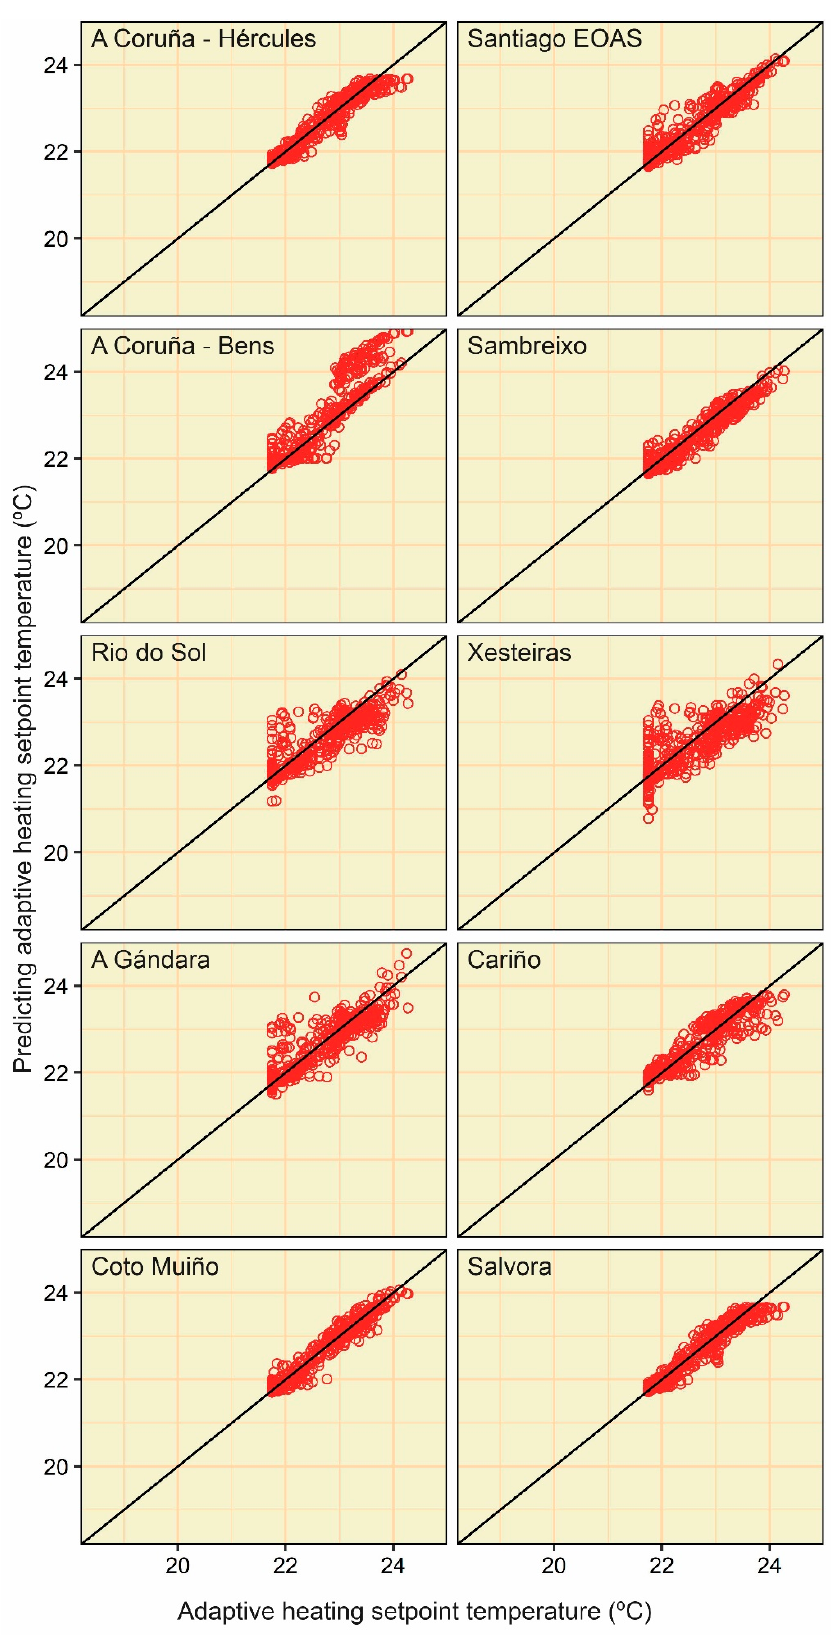
Figure A22. Point clouds between the actual and predicting adaptive heating setpoint temperature values (category I) of the MLP (approach 2).